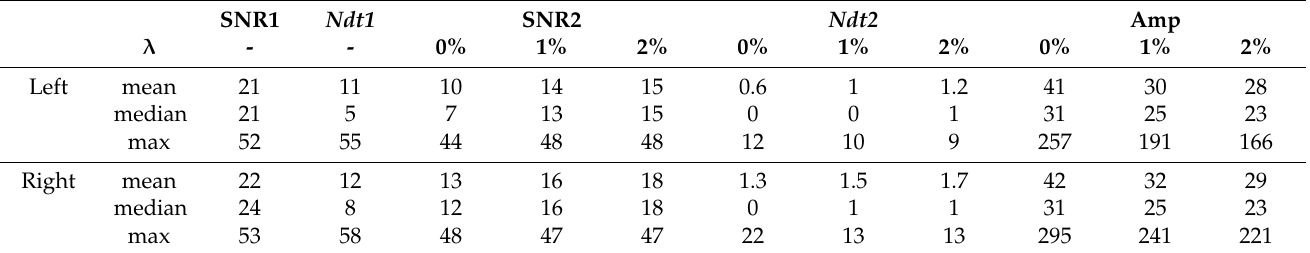
Table 4. Simulation 3: mean, median and maximum values of the sensor-level SNR1 (dB), source-level SNR2 (dB), number of montage channels with SNR >= 15 dB ( Ndt1 from the sensor-level and Ndt2